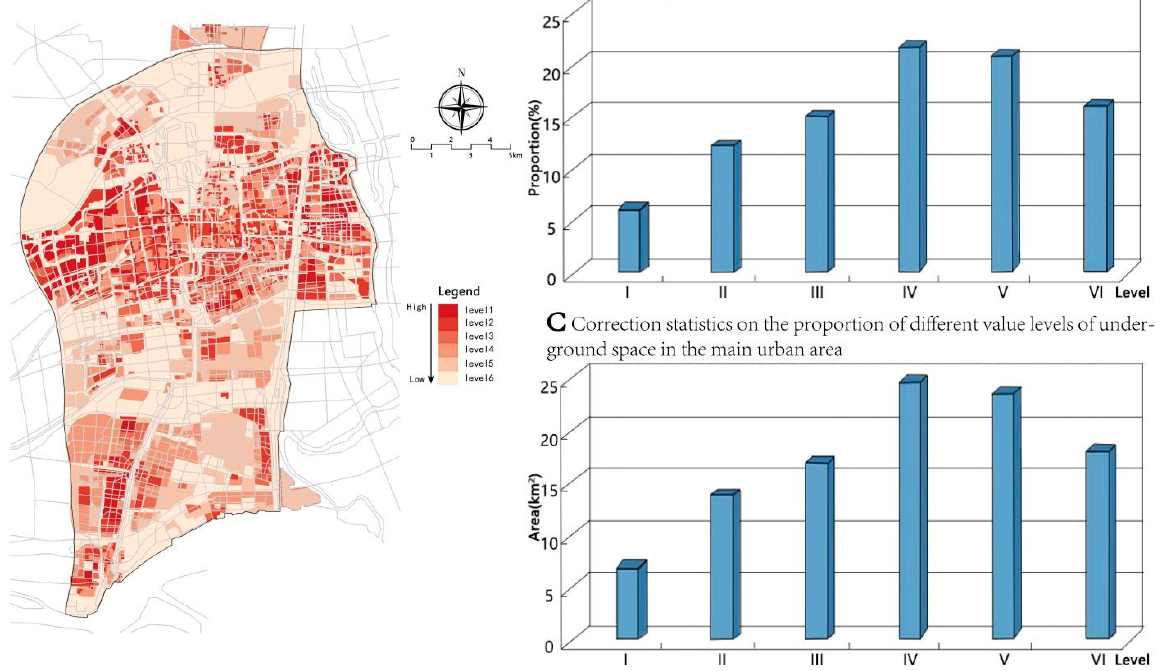
Figure 16. The value grade correction map of the underground space in the main urban area and the area and proportion value.